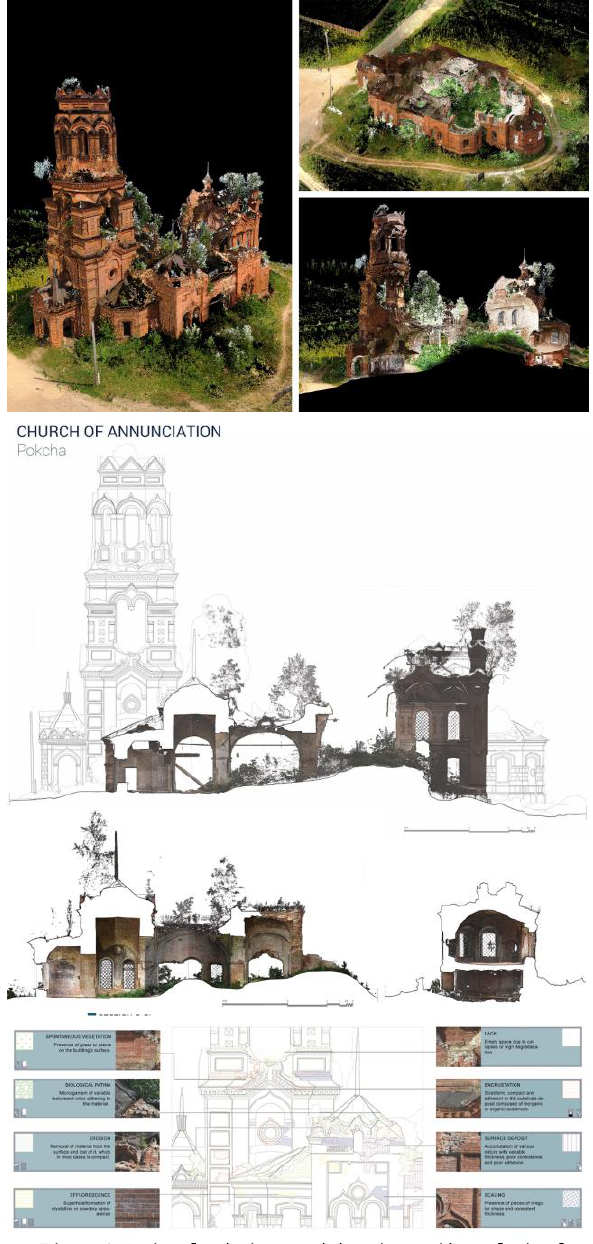
Figure 6. Point cloud views and drawings with analysis of the decay of the Church of